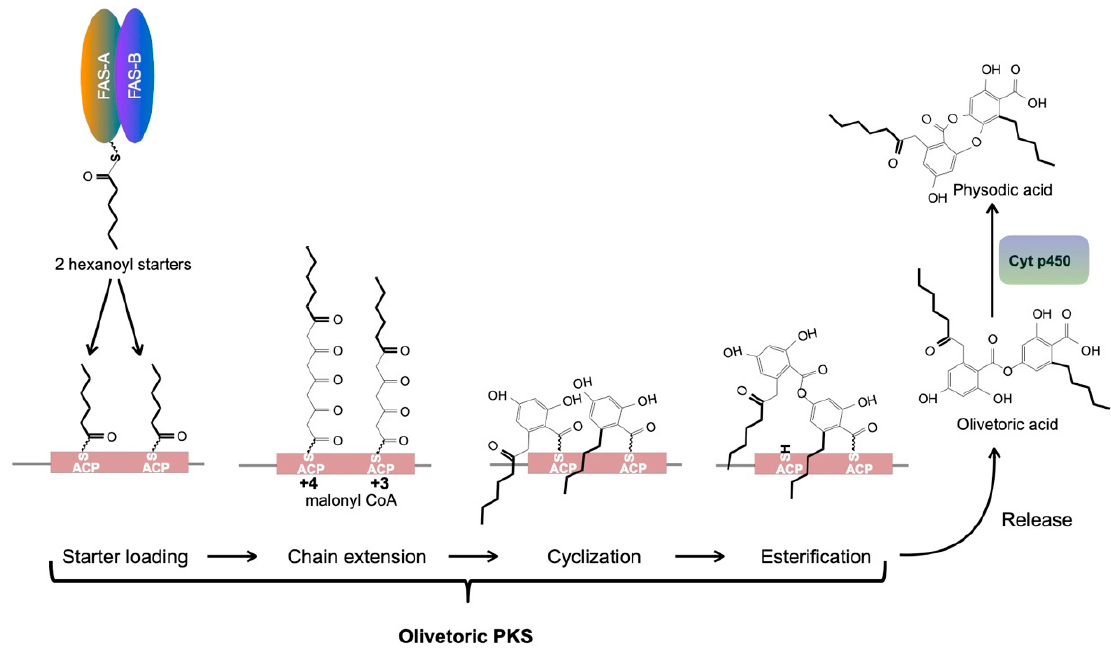
Figure 4. Putative scheme for depside/depsidone synthesis and function of FASs.